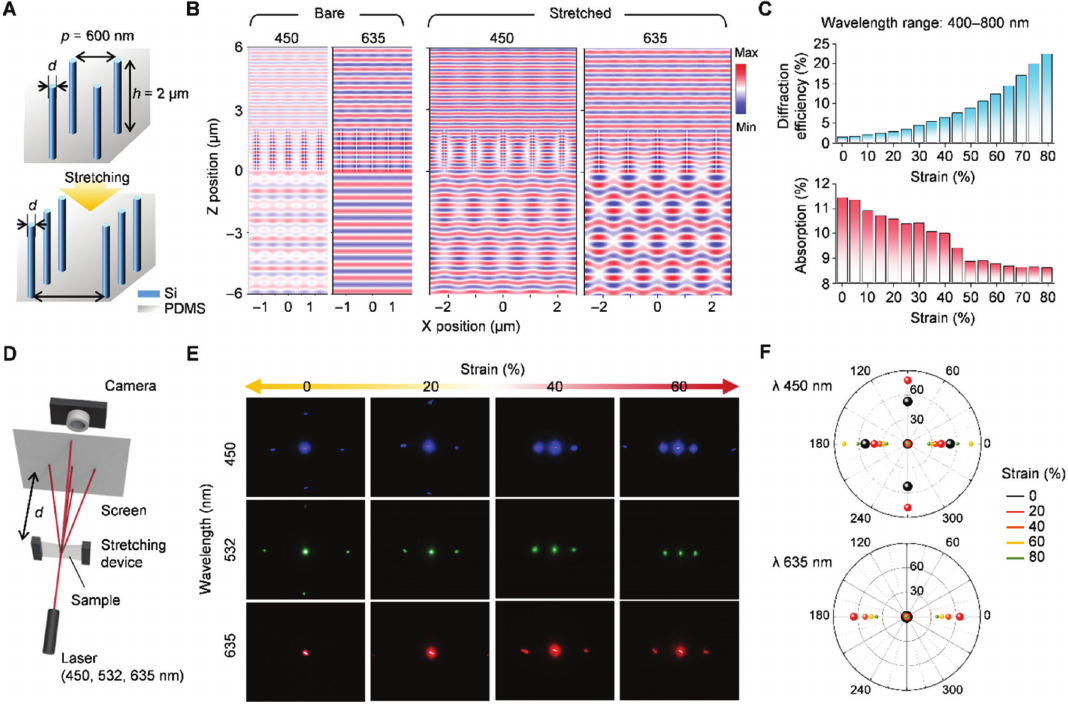
Figure 3: The simulation and experimental results for light diffraction properties. (A) Schematic illustration of the Si-NWAs embedded in PDMS. (B) The real part of electric-field distributions from three-dimensional finite- difference time-domain simulations. (C) Diffraction efficiency and averaged absorption depending on the applied strain with the wavelength range of 400–800. (D, E) Experimental setups and photographs for diffraction patterns. (F) Simulated diffraction patterns with the period 600 nm of